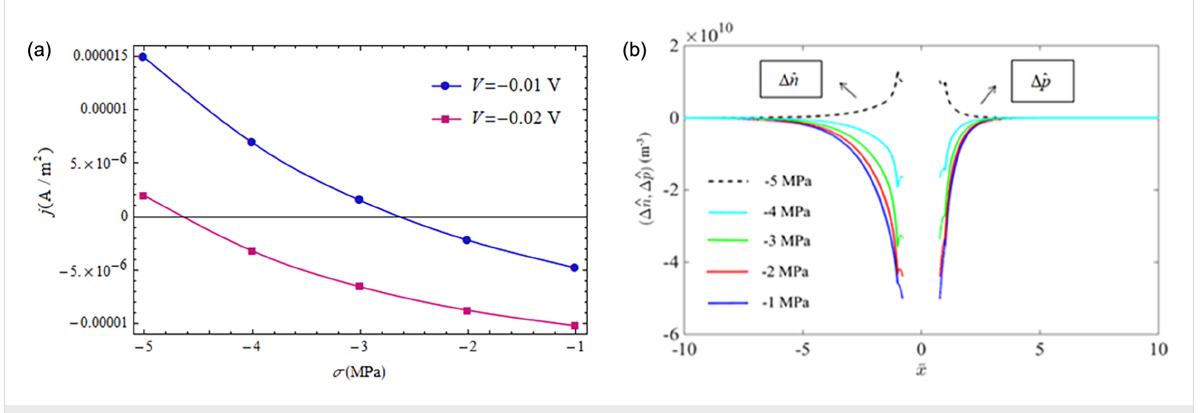
Figure 7: Positive current density under a reverse-bias voltage. (a) Current density under different applied compressive stresses and a fixed reverse- bias voltage; (b) NEMC under different compressive stresses at V = − 0.02 V.